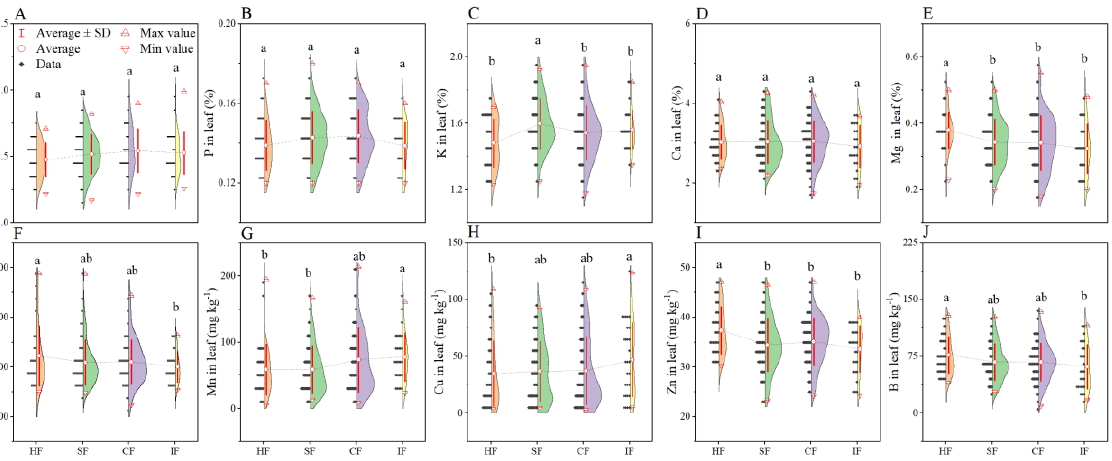
Figure 3. Contents of trace elements in leaves of Guanxi pomelo (Citrus grandis) with different grades. Each value represents mean ± standard errors. HF (47 samples): high-quality fruit, SF (97 samples): sub-quality fruit, CF (106 samples): Common fruit, and IF (31 samples): inferior fruit. ( A ) N: